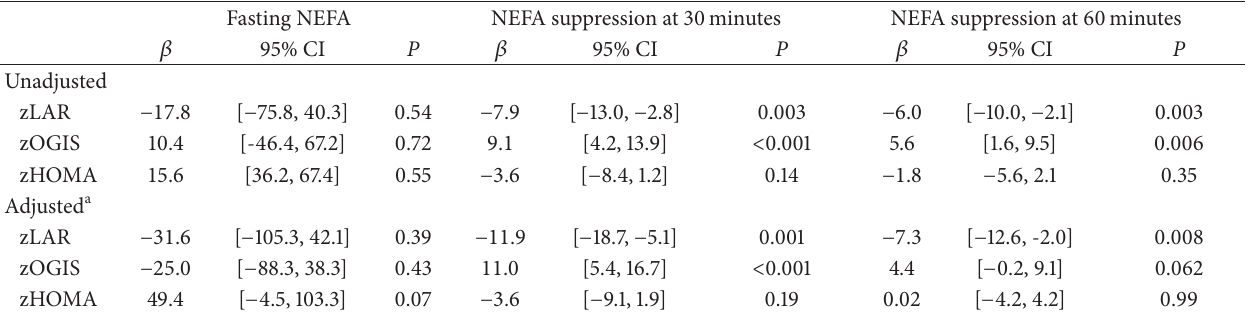
Table 2: Associations between standardised measures of insulin sensitivity (as exposures) and measures of NEFA metabolism (as outcomes). Fasting